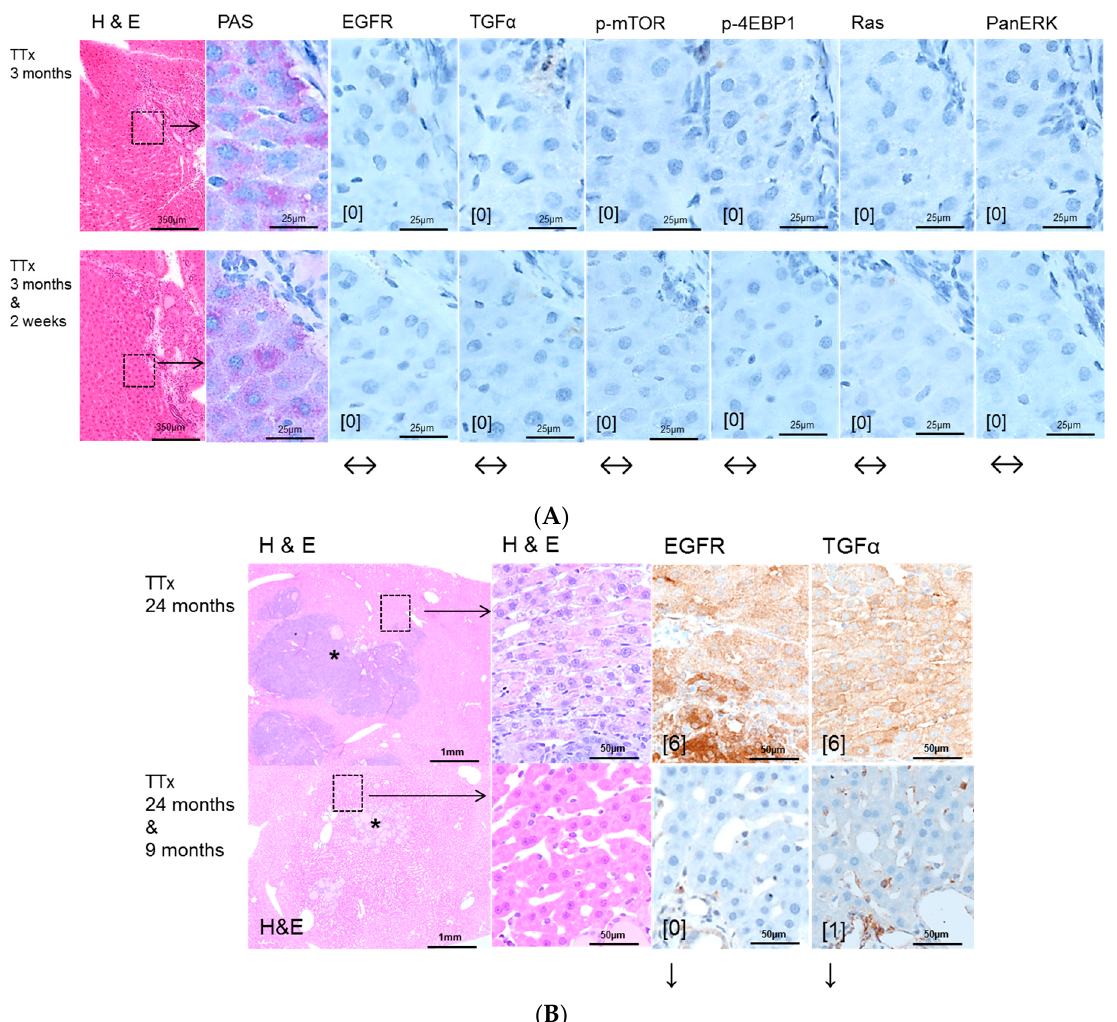
Figure 4. Effects of Gefitinib at three months after intraportal transplantation of thyroid follicles fragments in thyroidectomized rats (TTx) and expression patterns of EGFR and TGF α and downstream signaling pathways in pre-neoplastic foci of altered hepatocytes (FAH) and neoplastic liver lesions. Gefitinib was administered daily for nine months (10 mg/kg). ( A ) Short-term experiments . FAH of untreated rats (TTx 3 months) at the downstream level of transplanted thyroid follicles reveal loss of glycogen storage (PAS). There is no overexpression of EGFR and TGF α or of downstream signaling with representative p-mTOR, p-4EBP1, Ras and PanERK. After Gefitinib treatment for two weeks (TTx 3 months & 2 weeks), the EGFR and TGF α expression and downstream signaling is also not upregulated and thus not altered; ( B ) Long-term experiments (24 months). Transplanted follicles (*) and associated hepatocellular adenoma with strong overexpression of EGFR and TGF α of untreated rat (TTx 24 months) in comparison to treated rat (TTx 24 months & 9 months) with downregulation of EGFR and TGF α . Immunostaining scores are shown in brackets. Arrows correspond to ↑ upregulation, ↓ downregulation or ↔ unchanged expression level. Expression levels of immunostaining are given in brackets. Magnification: ( A ) 3 months/(3 months & 2 weeks) (H & E) 40 × ; marked area in dashed lines (PAS and immunostainings) 600 × ; ( B ) 24 months/(24 months & 9 months) (H & E) 40 × ; marked area in dashed lines (H & E and immunostainings) 400 ×.